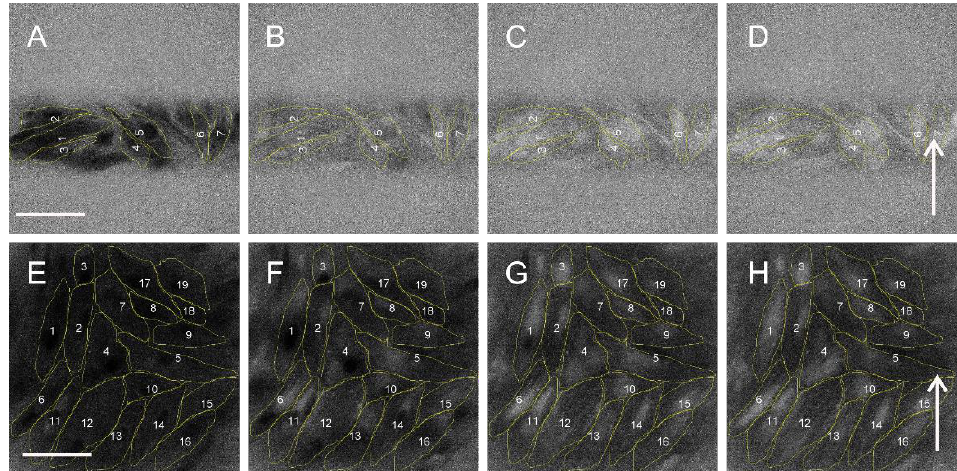
Figure 2. H9c2 cells exposed to a single 100 ns, 40 kV/cm ( A – D ) or 100 μs, 400 V/cm ( E – H ) electric pulse at different times with respect to pulse application: before pulse application ( A , E ), 1.75 s ( B , F ), 5 s ( C , G ), and 8 s ( D , H ) after pulse application. Figures are Fura-2 ratio 340/380 images, higher relative Ca 2+ concentration in cells is seen as brighter. In images ( A – D ), cells are seen only at the 100 µm gap between gold electrodes. Scalebar: 100 µm. Arrow: the direction of the electric field. When cells were exposed to 10 μs, 1000 V/cm (Figure 3E,F) or 100 μs, 400 V/cm pulses